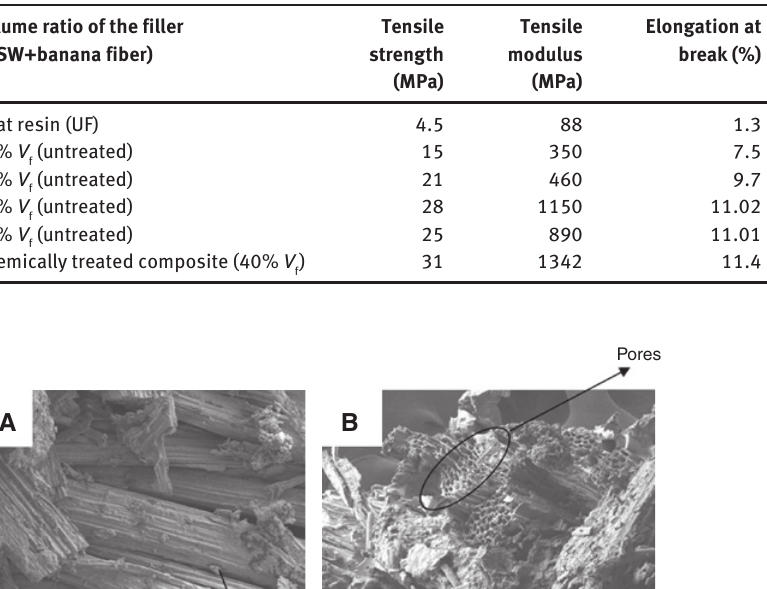
Table 3 Tensile, flexural and impact strength properties of untreated composites having different filler loading and treated composite at 40% V of filler (ratio of MSW/banana fiber = 50:50). f